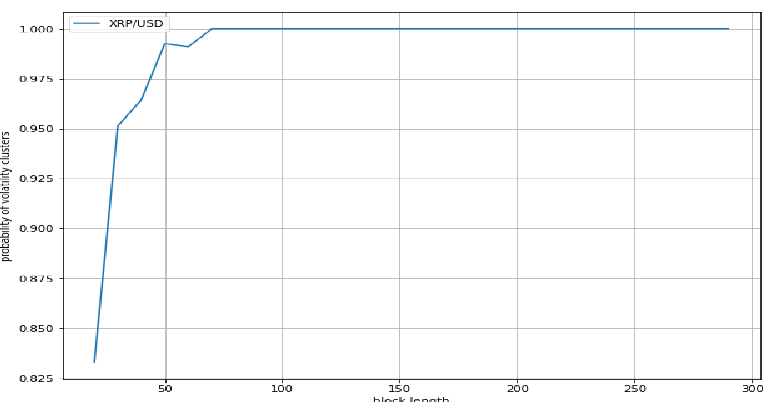
Figure 8. Probabilities of volatility clusters of the following cryptocurrencies. From top to bottom, Bitcoin/USD, Ethereum/USD, and